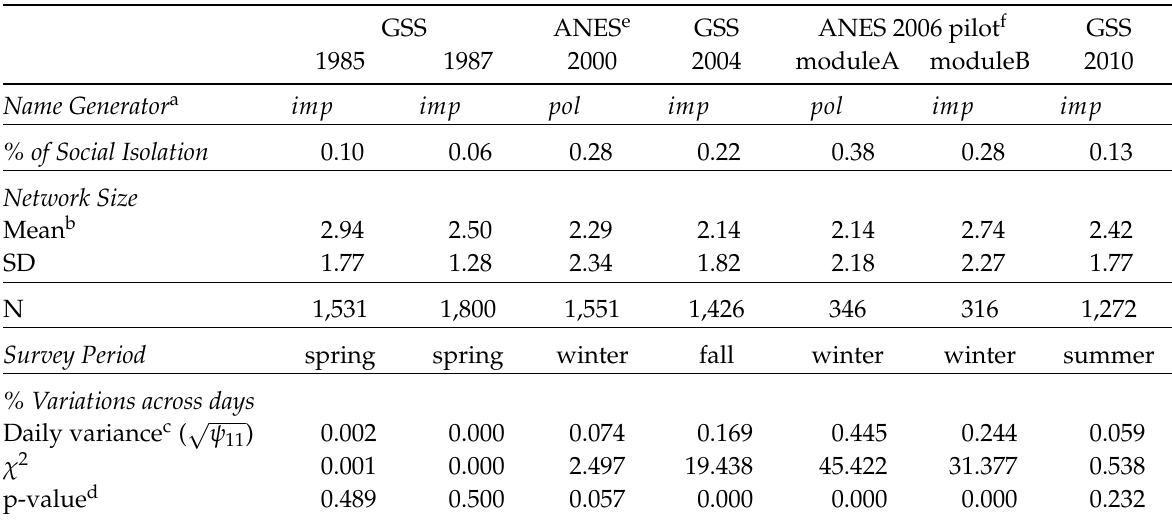
Table 1: Network size and its daily variations during survey period across different